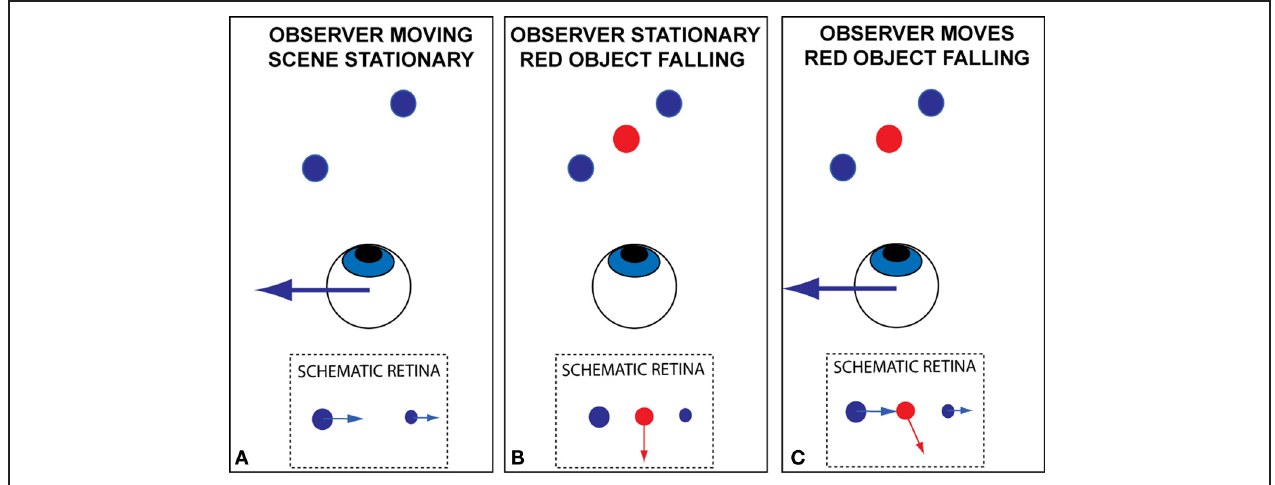
FIGURE 1 | Schematic illustration, in plan view, of the problem of recovering an appropriate estimate of scene-relative object movement when an observer is moving. Retinal motion occurs when (A) the scene is